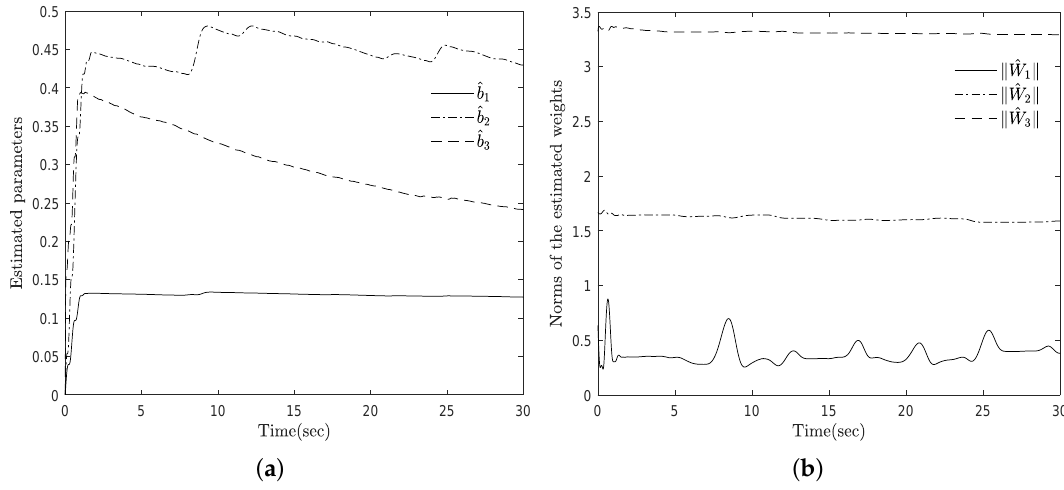
Figure 3. Estimation results of the proposed approach for Example 1 ( a ) ˆ b i ( b ) (cid:107) ˆ W i (cid:107) for i = 1,2,3.